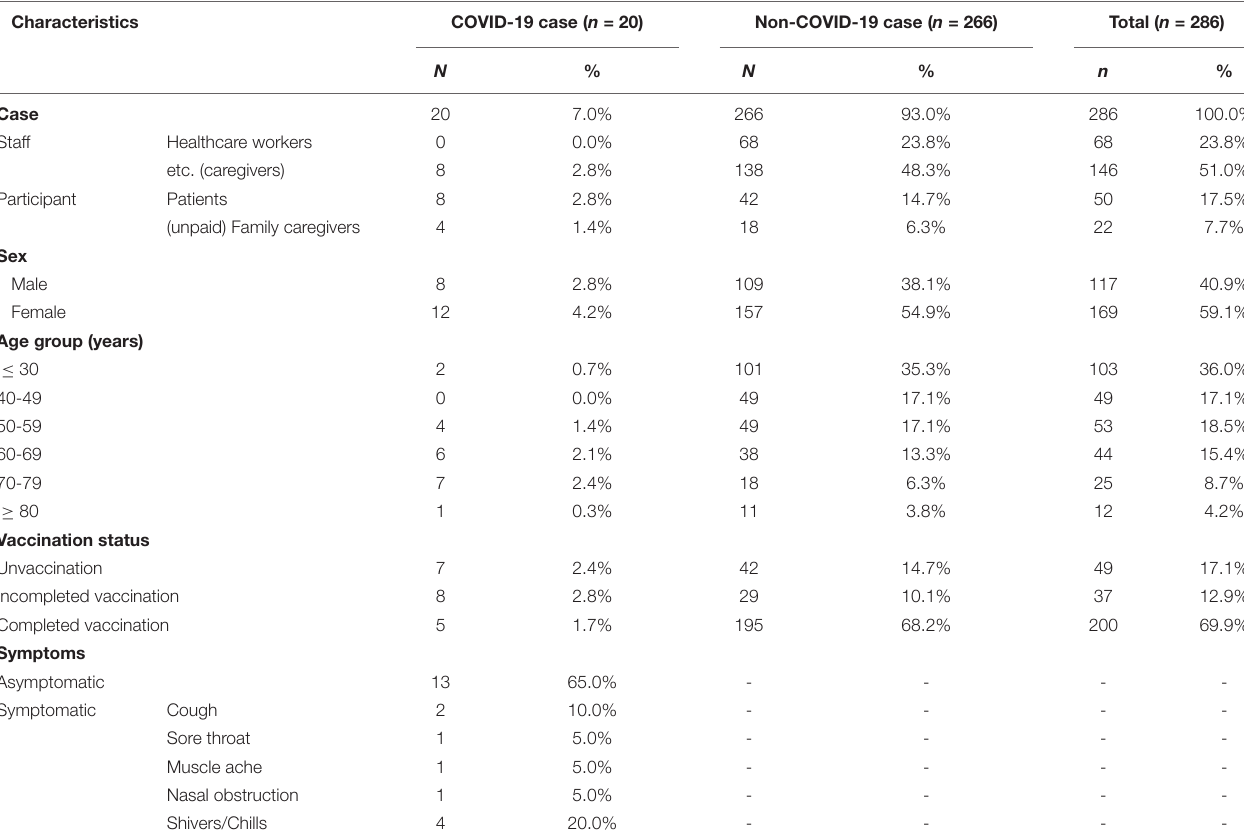
TABLE 3 | Epidemiological characteristics of confirmed cases for the COVID-19 outbreak at the general hospital in Jeju Island, Republic of Korea, in August 2021. Characteristics COVID-19 case ( n =